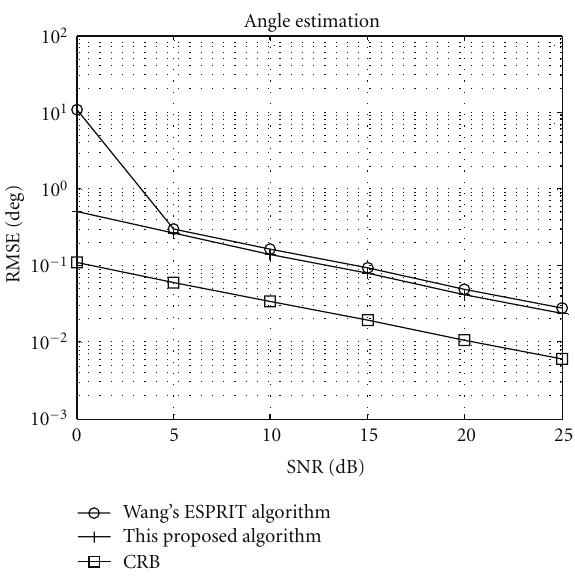
Figure 3: Angle estimation performance comparison at M = 12, K = 3, P = 3, and N = 100.